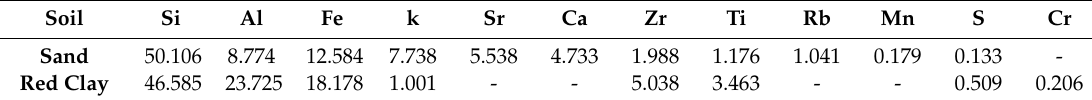
Table 4. X-ray fluorescence (XFR) analysis of two soils, values in (%).